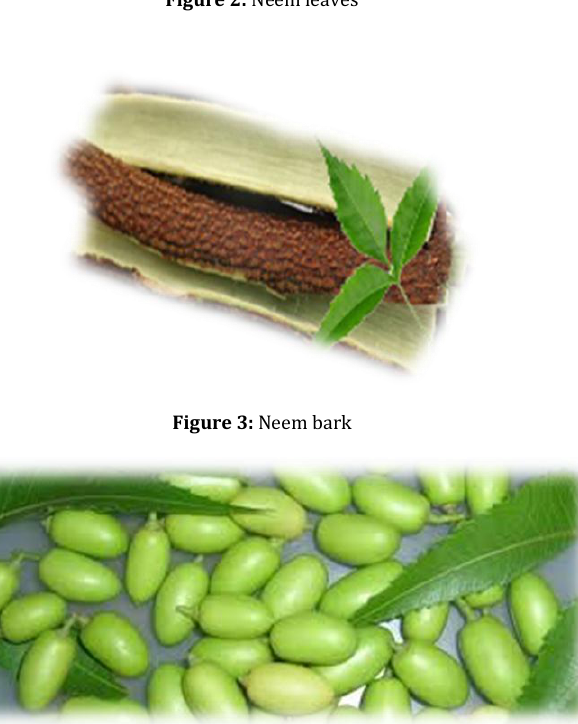
Figure 2: Neem leaves